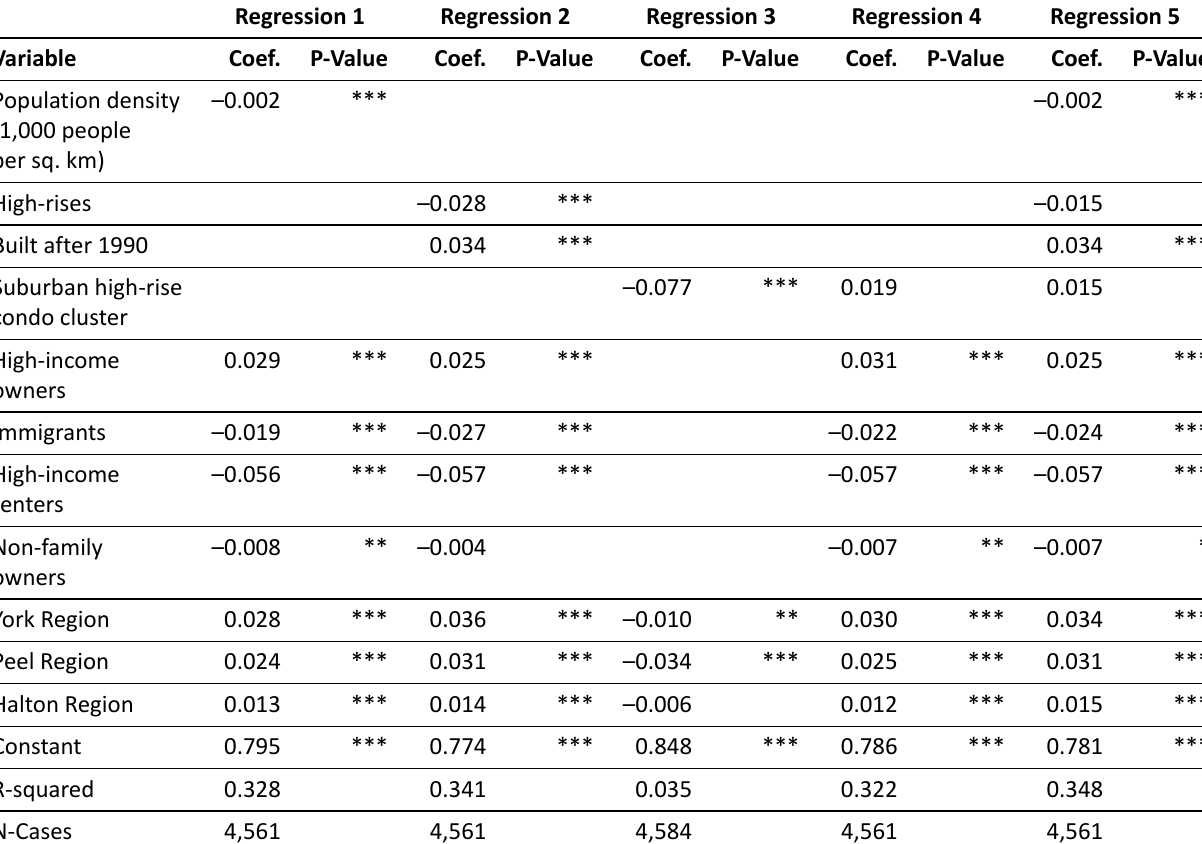
Table 4. Automobile commuting in suburban municipalities as a function of built form and demographic characteristics. Source: authors’ calculations using 2016 Statistics Canada DA